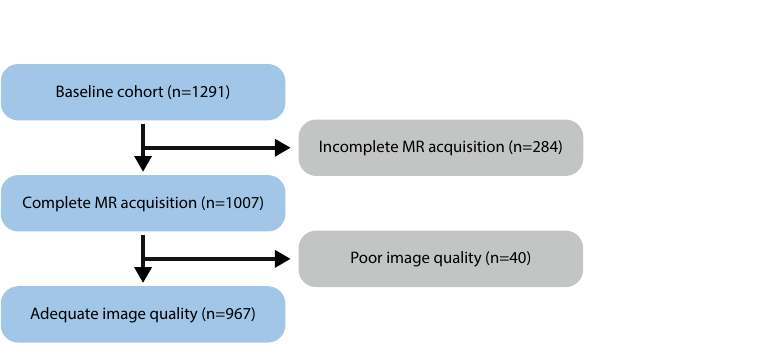
Table 1. Demographics of the patient groups with and without brain infarct, used for the training/training- validation, and validation/test sets, respectively.